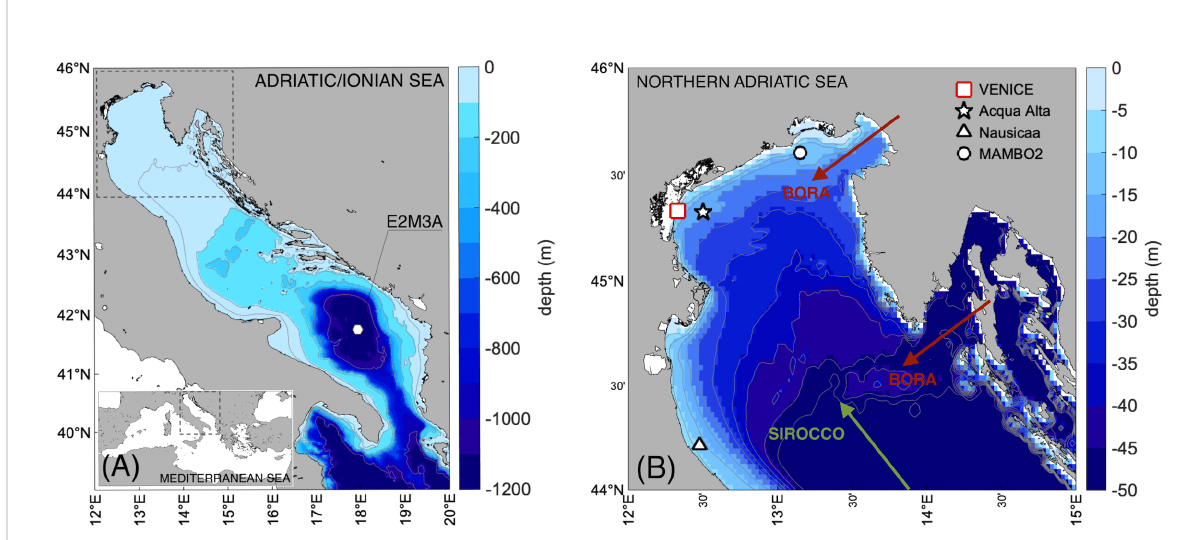
FIGURE 1 PELMO wave model computational grid (physical space). (A) Adriatic/Ionian Sea grid (colored region) and bathymetry. The Mediterranean Sea region is shown in the bottom-left corner. (B) northern Adriatic Sea zoom (target zone, dashed line square in (A) . Venice lagoon and the four stations for in-situ measurements used in the study ( “ Acqua Alta ” , “ Nausicaa ” , “ E2M3A ” , “ MAMBO2 ” ) are shown in (A, B) Principal winds in the northern Adriatic Sea (northeasterly Bora and southeasterly Sirocco) are shown as arrows in (B)